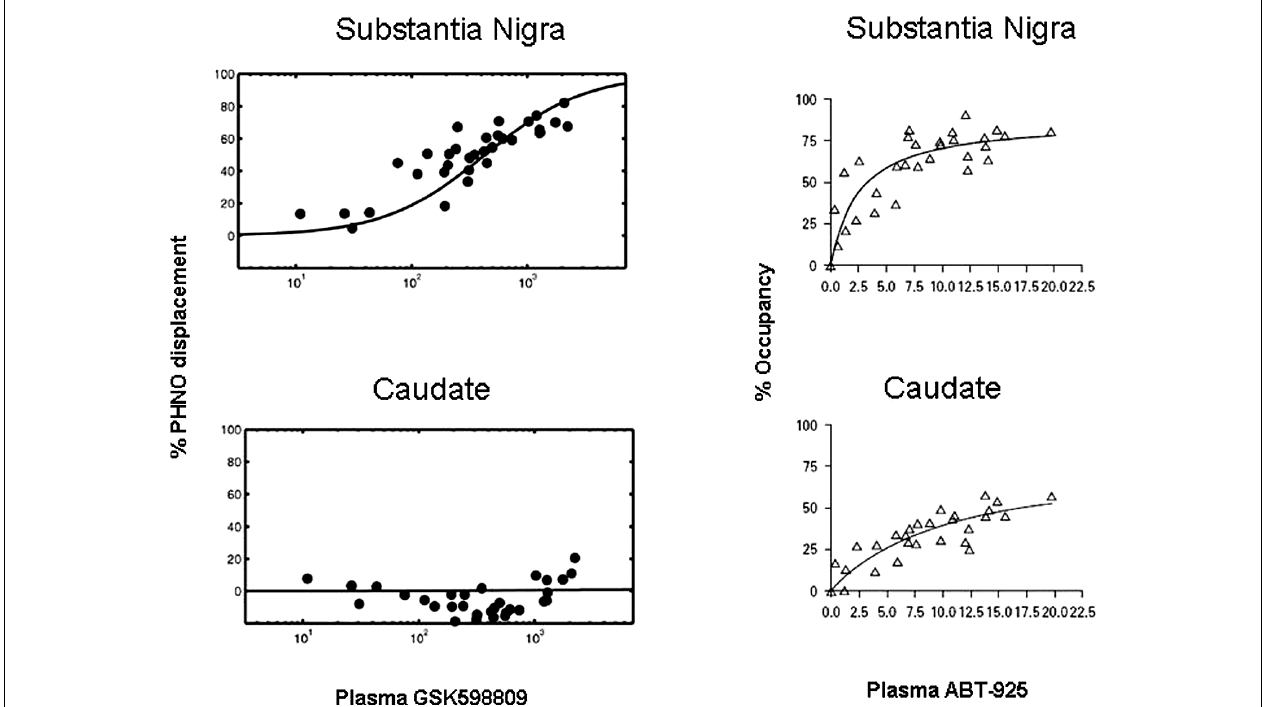
GSK598809 and ABT-925 almost completely blocked the specific binding of [ 11 C]-( + )-PHNO in substantia nigra, with negligible effects on the caudate for GSK598809 and limited effect on the caudate for ABT-925. With permission from Searle etal. (2010) and Graff-Guerrero etal.